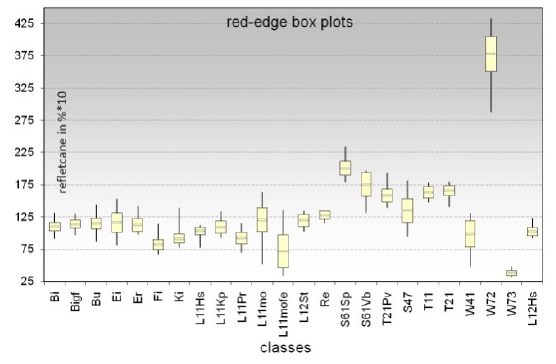
Figure 3. red-edge box plots.